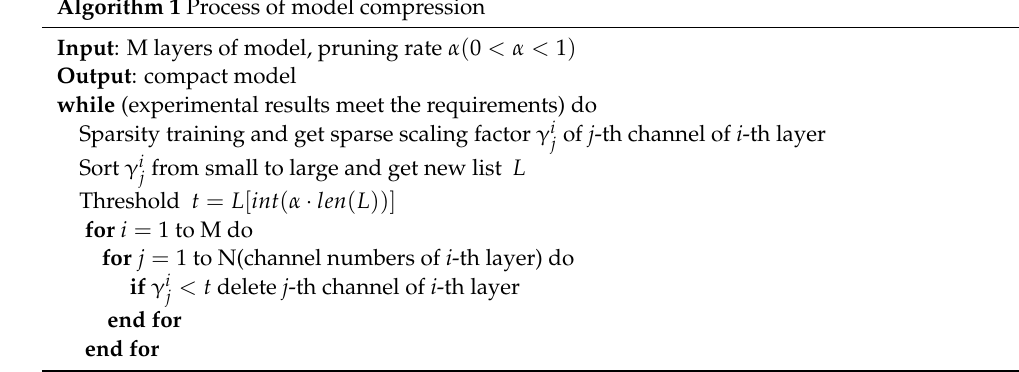
Algorithm 1 Process of model